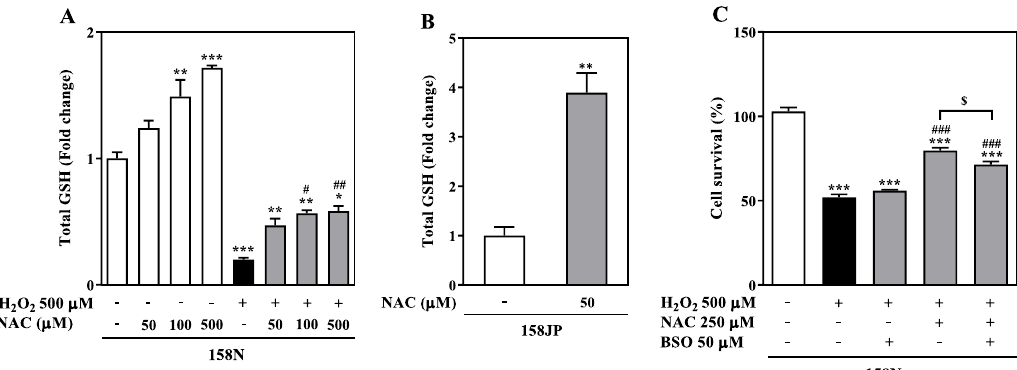
Figure 3. Inhibition of antioxidant glutathione (GSH) synthesis partially blocks the protective e ff ect of NAC. ( A ) Total GSH was analyzed following treatment of 158N cells with NAC (50 to 500 µ M) either alone or in combination with H 2 O 2 (500 µ M) for 24 h. ( B ) 158JP cells were treated only with NAC (50 µ M) for 24 h. Total GSH was calculated relative to the control (untreated) cells, and results expressed as fold change. ( C ) 158N cells were treated with H 2 O 2 (500 µ M) for 24 h with and without NAC (250 µ M) and L-buthionine-(S,R)-sulfoximine (BSO), a GSH synthesis inhibitor (50 µ M). Cell survival was calculated as the percentage of control cells and the results were expressed as mean ± SEM. Total GSH levels was analyzed using LC–MS, and cell survival quantified by a colorimetric method. The data were analyzed by one-way ANOVA with Tukey’s post-hoc test ( A , C ) and an unpaired Student’s t -test ( B ). *** p < 0.001, ** p < 0.01 and * p < 0.05 shows statistical significance between control and treated groups. ### p < 0.001, ## p < 0.01 and # p < 0.05 shows significance between H 2 O 2 alone and